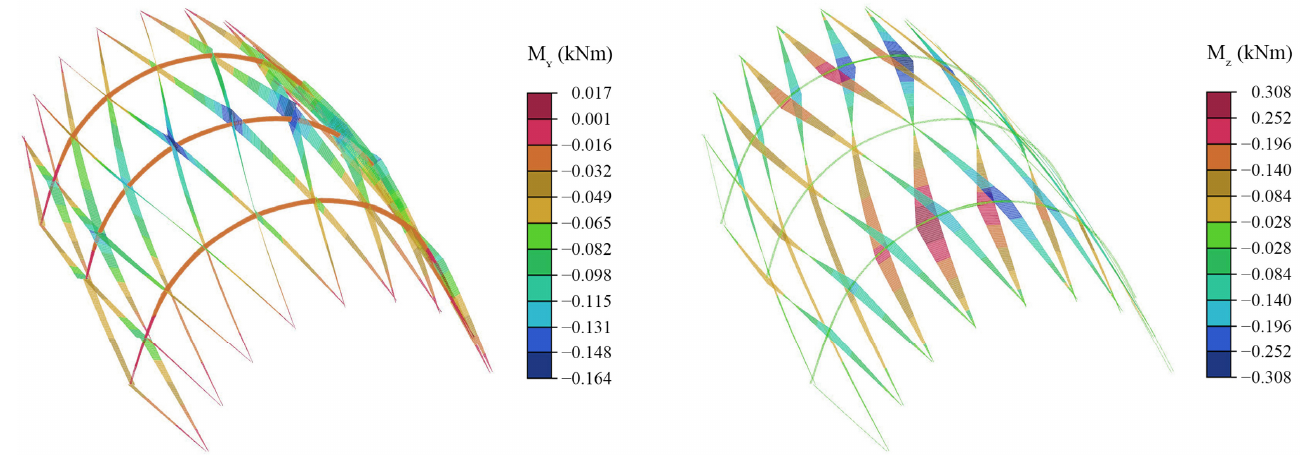
Figure 15. Model A with semi-rigid connections: residual bending moment.